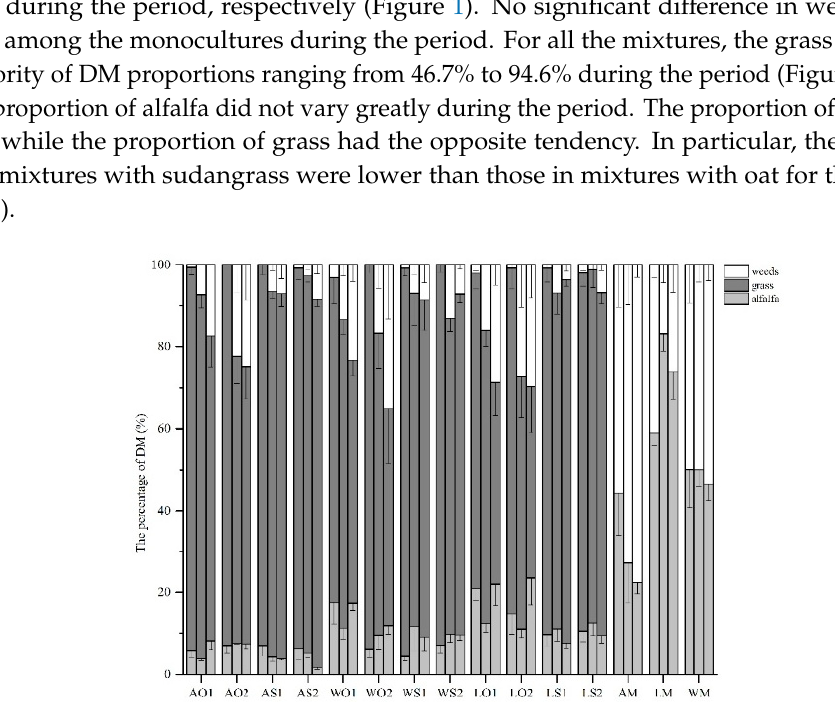
Figure 1. The percentage of DM among all treatments during the growing season (mean ± SE). The three columns in each treatment represent the DM proportions of June, July and August, respectively. The abbreviations are the same as above.